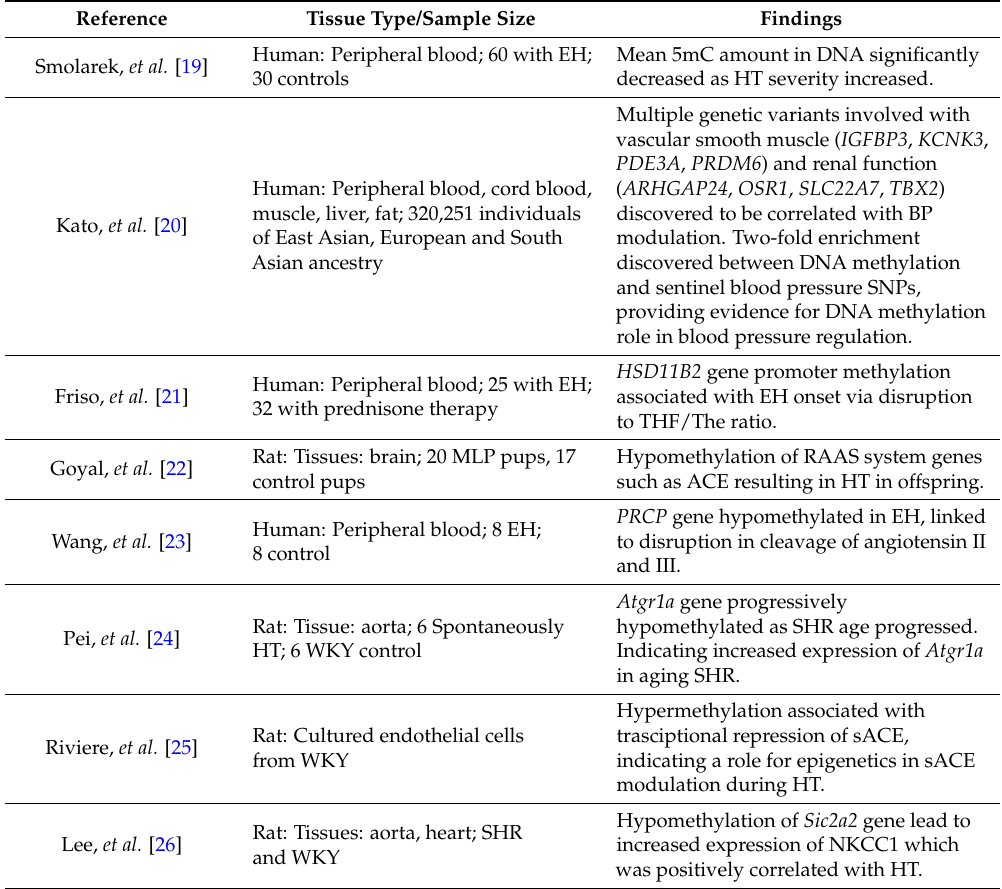
Table 1. Summary of methylation findings in relation to